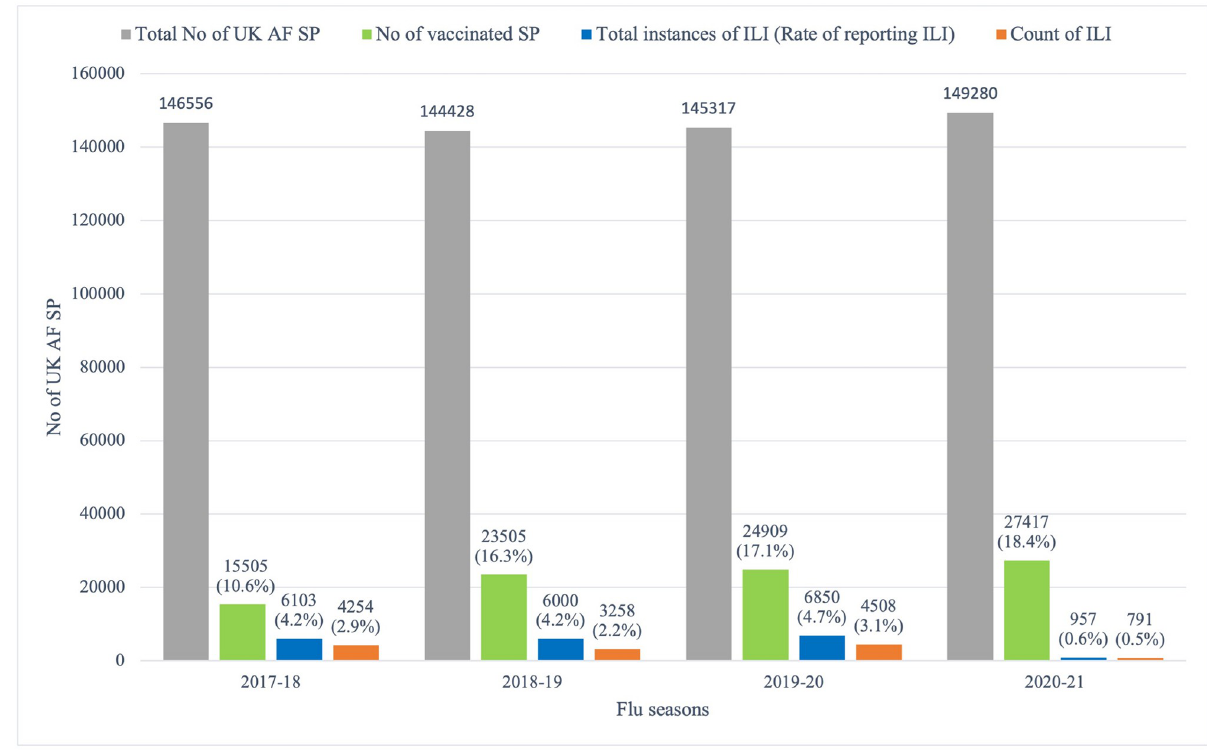
Fig 1. Total number of SP; vaccination rate; rate of reporting ILI; and count of ILI in the UK AF before and during the COVID-19 pandemic.